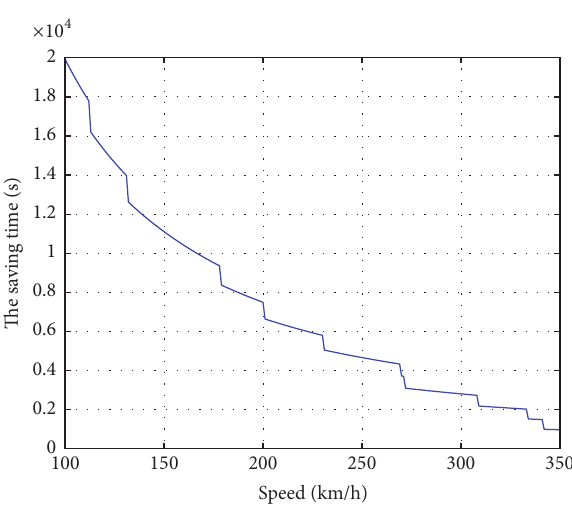
Figure 7: The saving time of one routing of variable approach locking section.